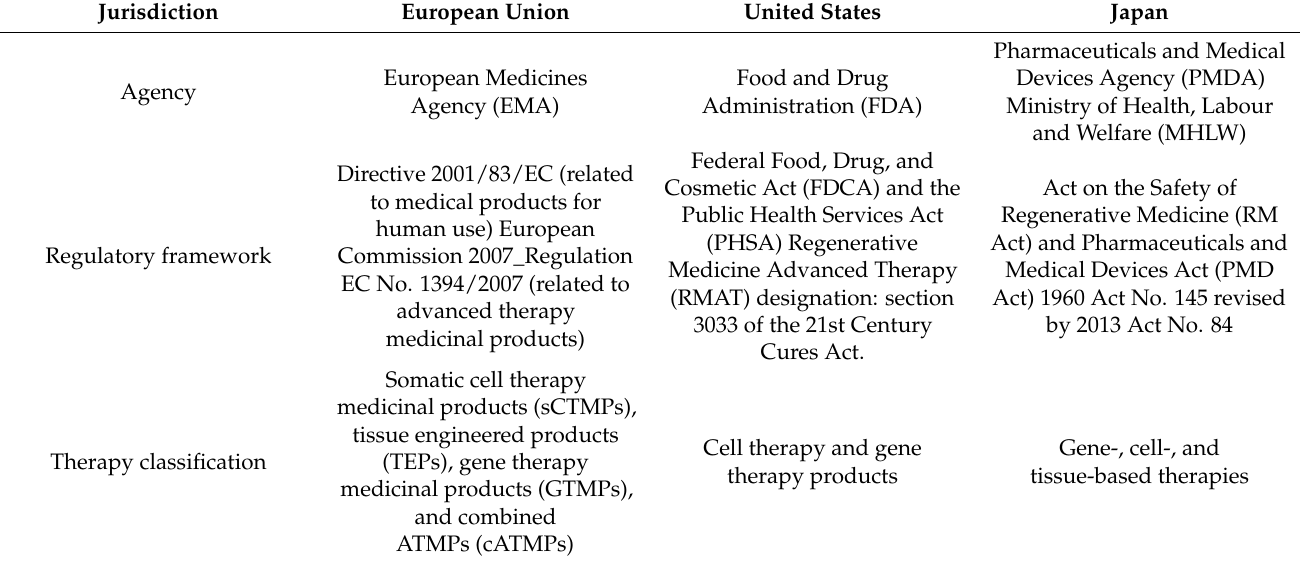
Table 1. Regulatory framework for cell- and gene-based therapies in the European Union, the United States, and Japan.